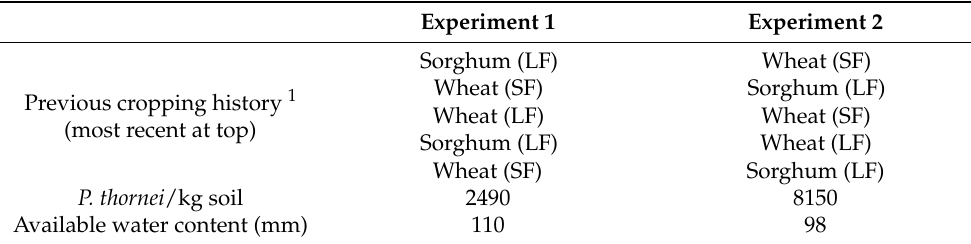
Table 1. The previous cropping history of each experimental site, Pratylenchus thornei /kg soil and available water content (mm) (calculated from data from individual soil depth intervals shown in Supplementary Table S1) at 0–0.9 m soil depth one month before starting the experiments at Formation, Queensland, Australia. Previous cropping history 1 (most recent at top)